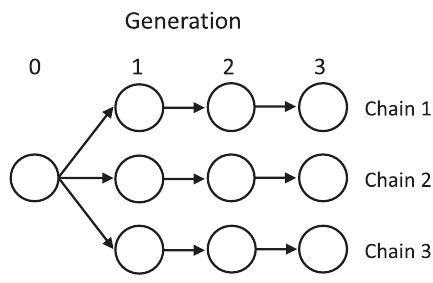
Fig. 2 Linear transmission chain structure. All chains in the same transmission and participant age condition received input from the same Generation 0 or ‘ seeded ’